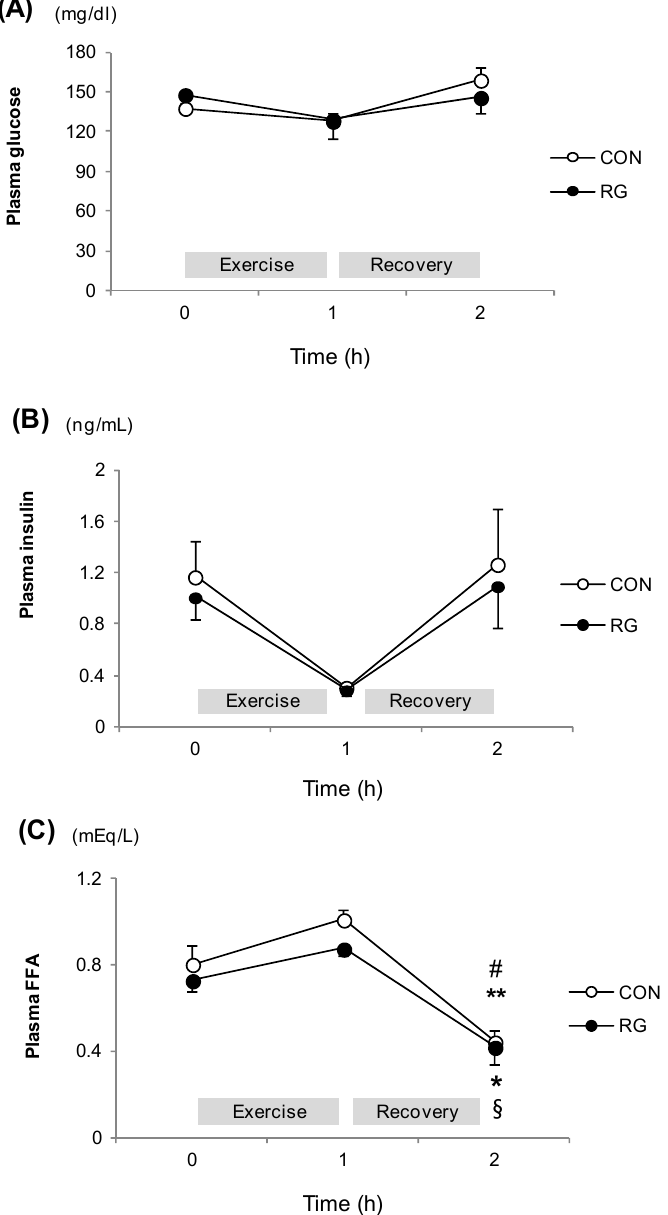
Figure 2. The change in plasma parameters during exercise and after exercise for one